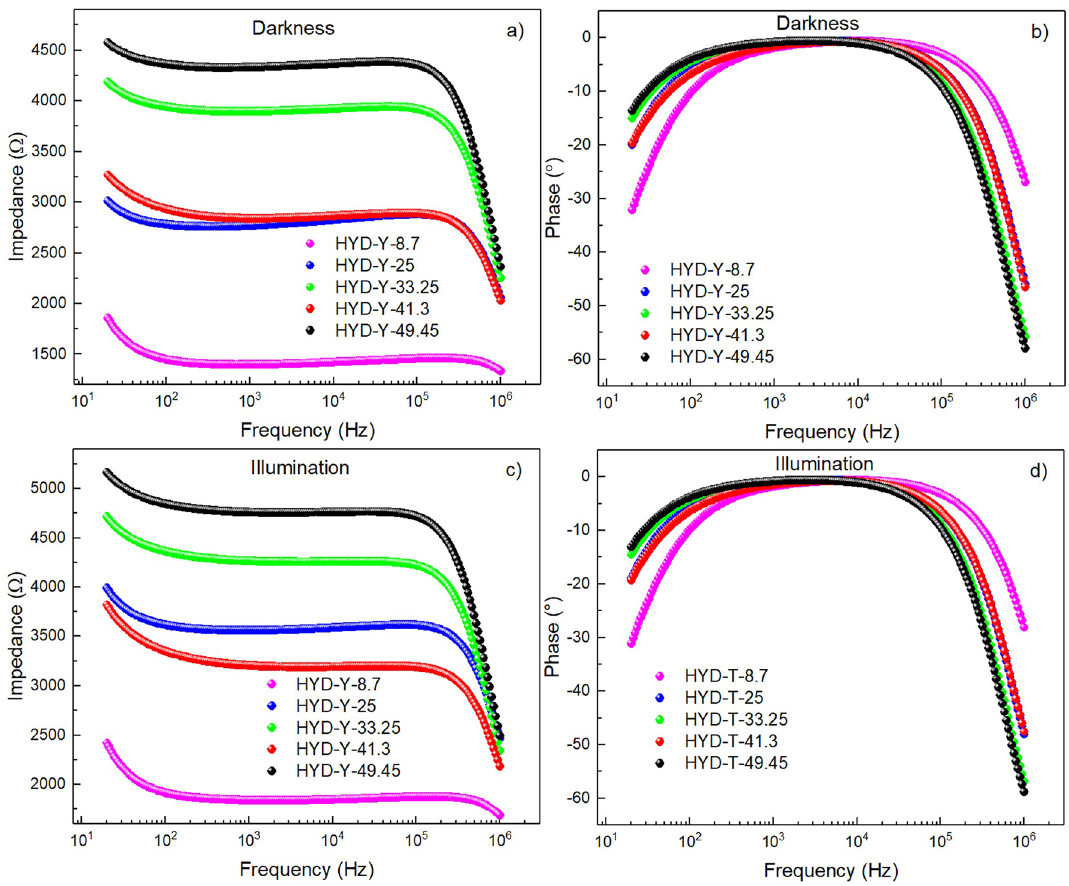
Figure 7. Bode plots of the samples HYD-T in dark ( a ) impedance, ( b ) phase; under illumination, ( c ) impedance, and ( d )